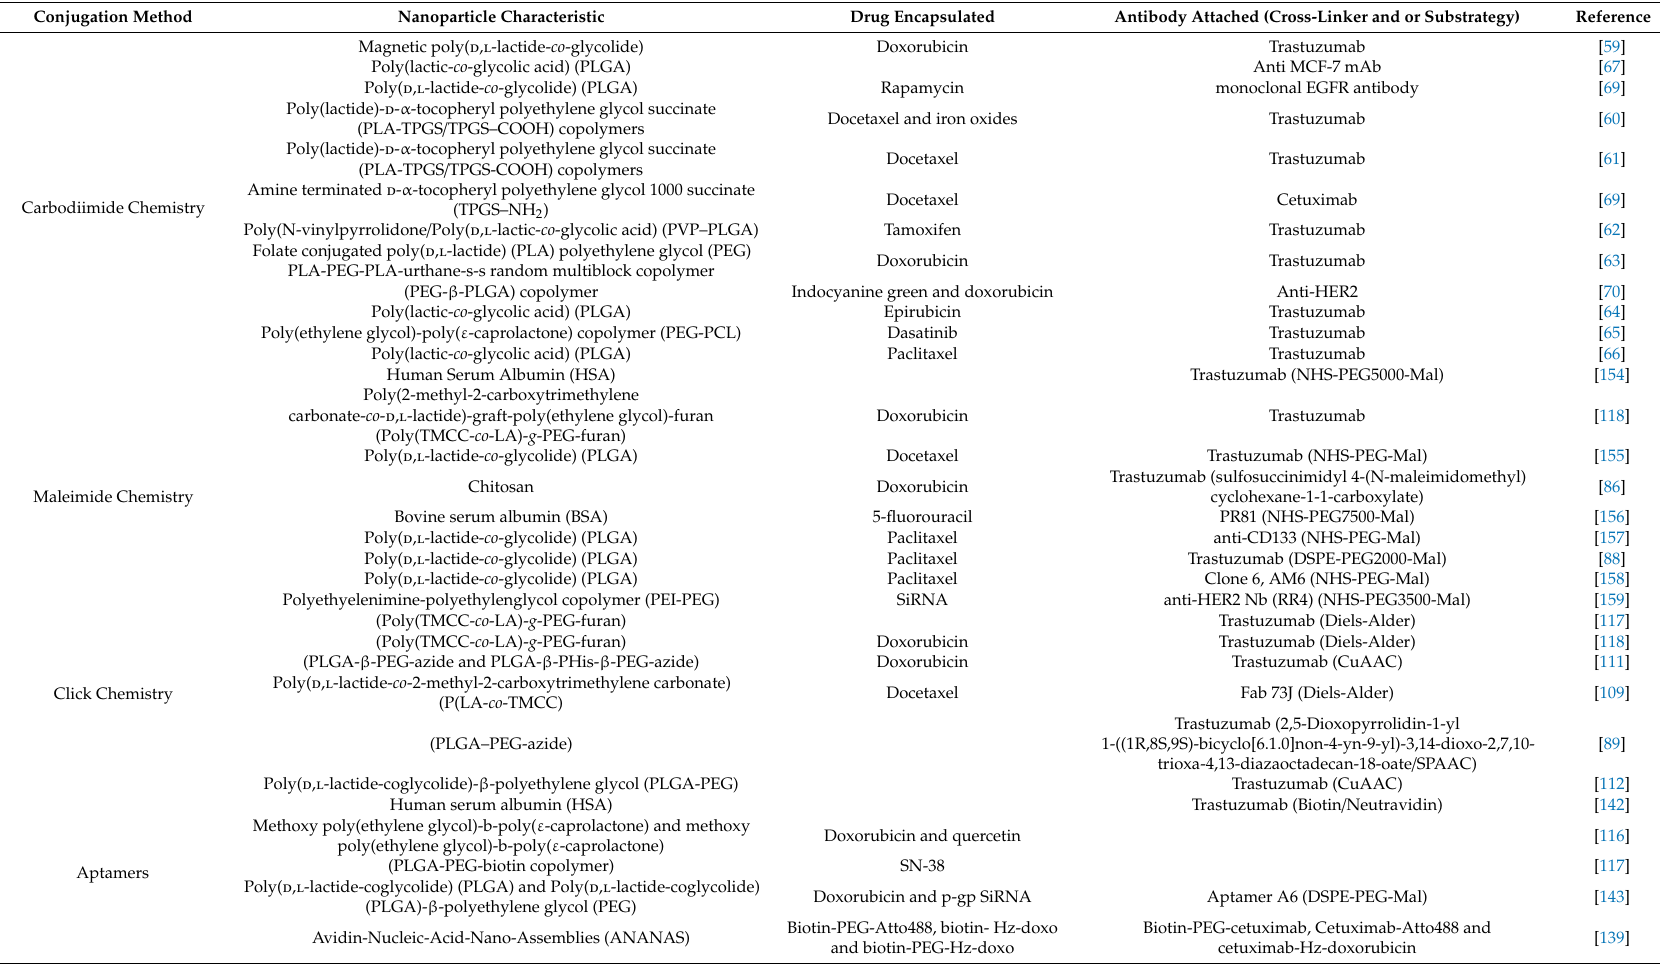
Table 1. Main reported works on antibody conjugation strategies of polymeric NPs for the breast cancer